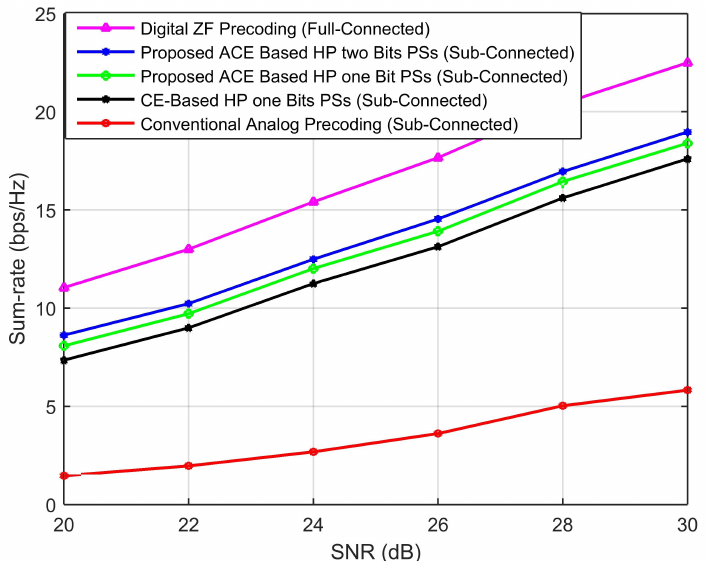
Figure 3. Sum-rate of ACE-based method with sub-connected PSs when C = A = 10 and users and RF chains are 4.